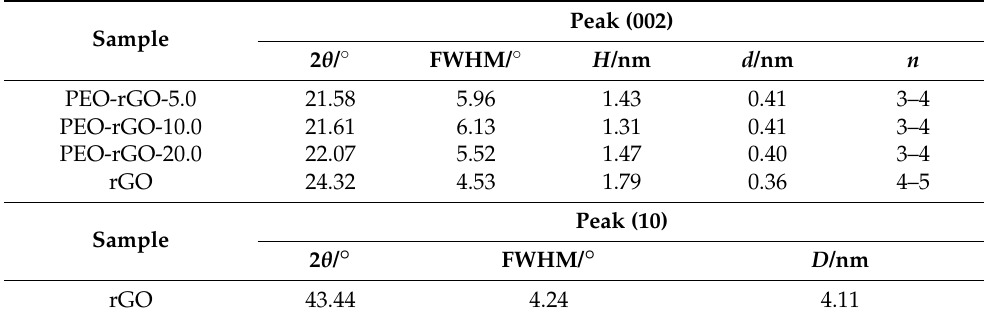
Table 1. Structural parameters of the rGO-powder and the electrospun PEO/rGO-based nanocom- posites resulting from the XRD patterns. Notation: H —average height of the stacking nanolayers; n —average number of graphene layers in graphene stacking nanolayers; d —average distance between graphene layers; D —average diameter of rGO stacking